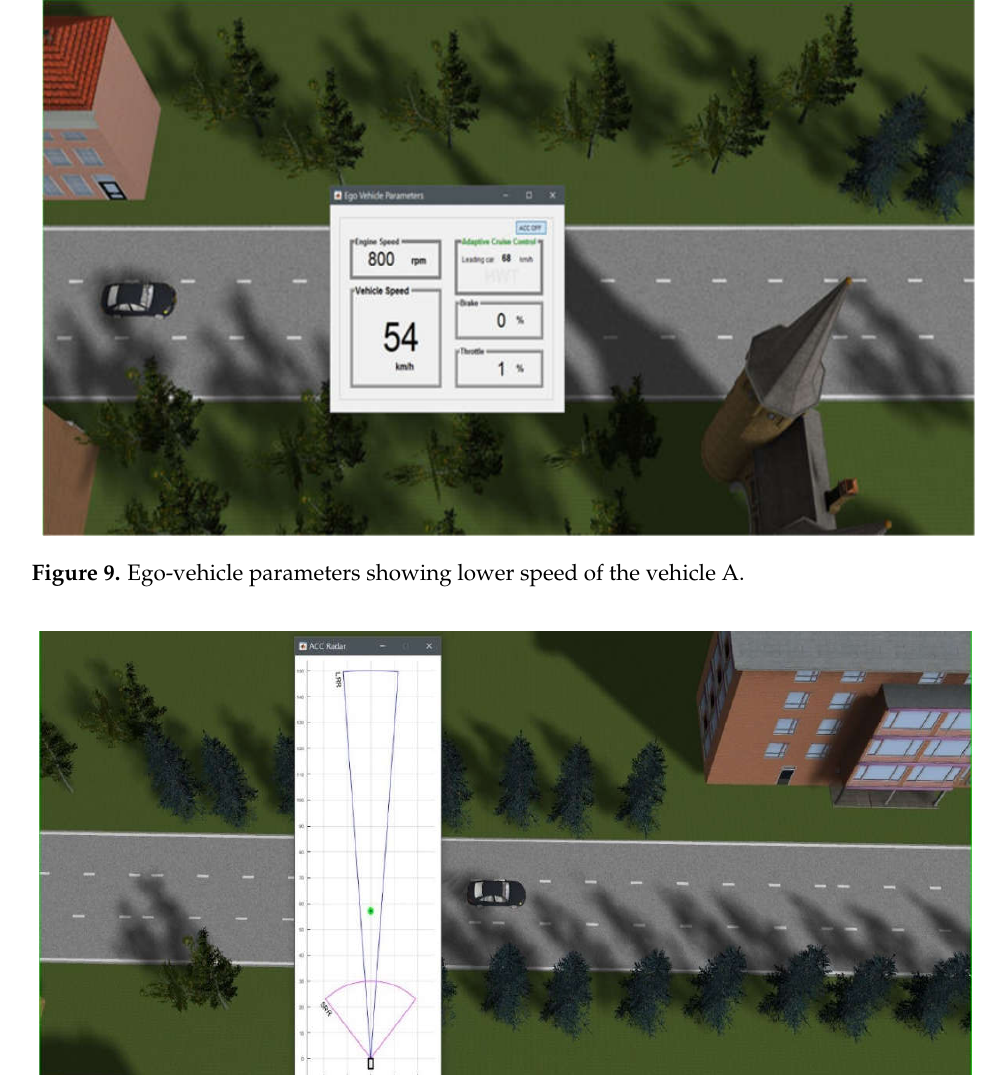
9 of 16 Figure 8. Scheme of overtaking-maneuver phases. 4.1. Phase 1